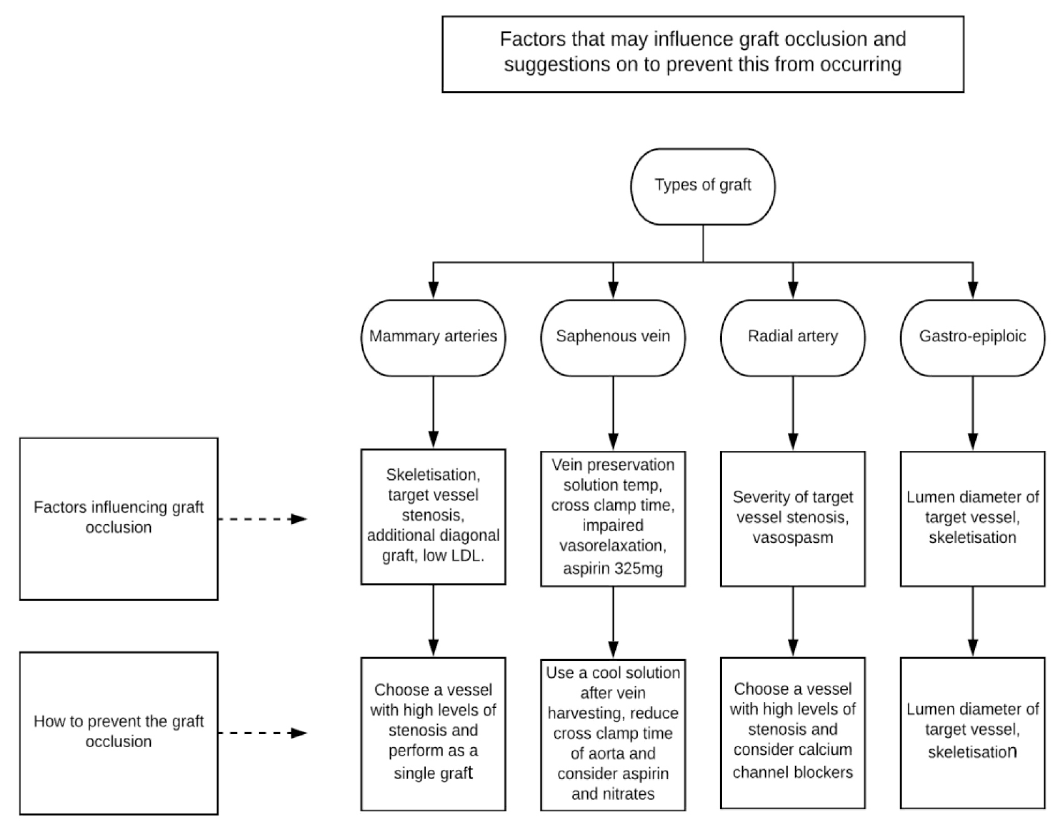
Fig. 2 – Methods of minimizing graft occlusion. LDL=low-density